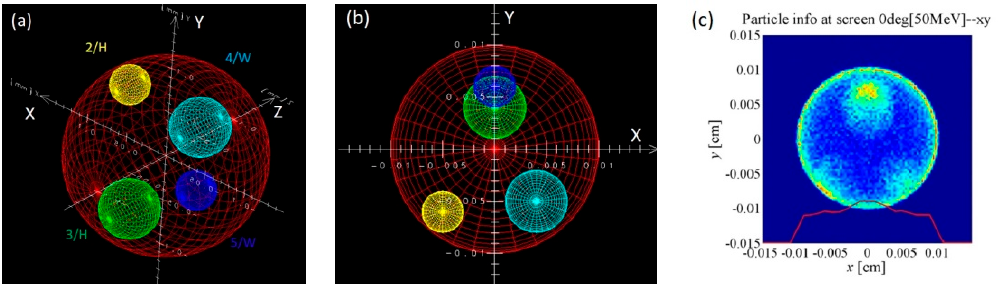
Figure 5. The complicated sample used for TDHEER simulation studies, ( a ) the sample structures with four small balls inside, ( b ) the sample structures with four small balls inside the reverse projection in the x - y plane, and ( c ) the HEER image of the sample with 0-degree